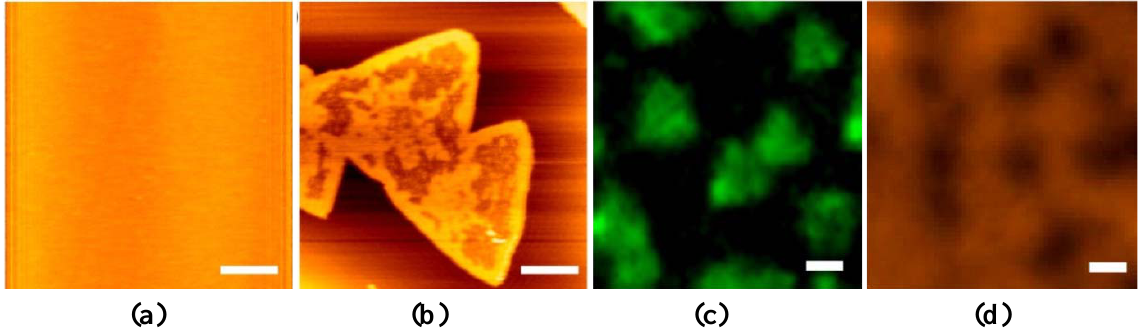
Figure 6. ( a , b ) AFM topographies of SM + Chol + GM1-SLBs on mica ( a ) just after preparation and ( b ) after incubation at 37 °C for 24 h; ( c , d ) Fluorescence images of SM+Chol+GM1-SLBs similarly prepared to Figure 6b assaying ( c ) SM by doping NBD-SM and ( d ) GM1 by addition of CTX-B labeled with Alexa555. Scale bars are 1 µm. Reprinted from [137] with modification with permission from Elsevier.